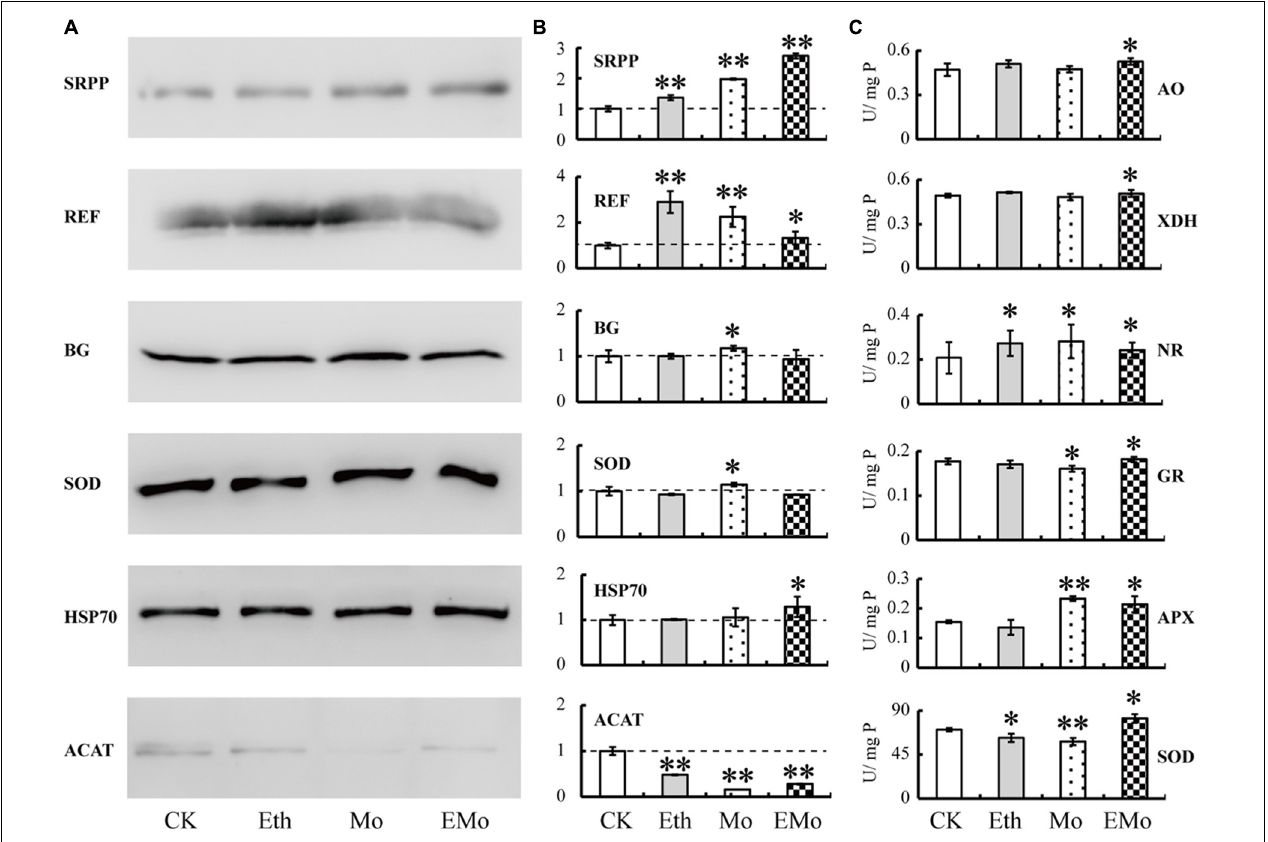
FIGURE 7 | Western blotting and enzyme activity assay of Mo-responsive enzymes. The accumulation patterns of six DEPs from rubber latex under different treatments (Eth, Mo, and EMo) were examined by Western blotting (A) . The means of the relative abundance to CK were calculated from three independent experiments. Values are the mean ± SD ( ∗ P ≤ 0.05 and ∗∗ P ≤ 0.01). The dotted line represents the relative abundance value in CK (B) . The enzyme activities of six Mo-related enzymes were examined (C) . U/mg P value represents the specific activity of the enzyme and also means the number of enzyme activity units in unit protein. Values are the mean ± SD ( ∗ P ≤ 0.05 and ∗∗ P ≤ 0.01). SRPP, small rubber particle protein; REF, rubber elongation factor; BG, beta glucosidase; SOD, superoxide dismutase; HSP70, heat-shock 70 kDa protein; ACAT, acetyl-CoA acetyltransferase; APX, ascorbate peroxidase; GR, glutathione reductase;